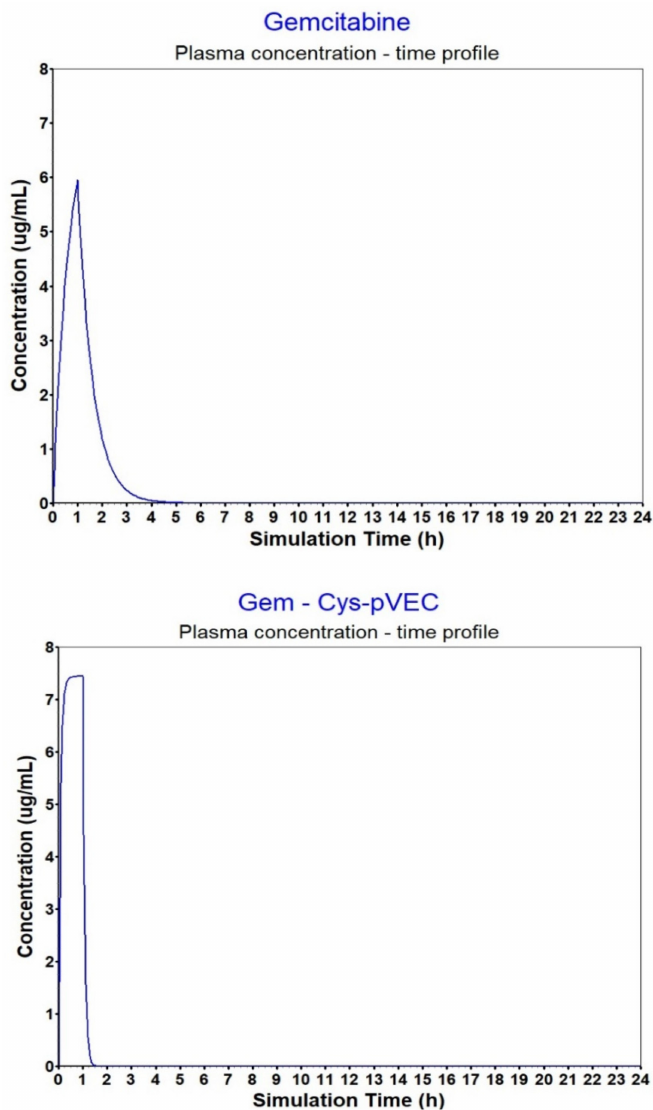
Figure 3. Plasma concentration–time profiles for gemcitabine and the Gem-Cys-pVEC conjugate after IV infusion (1